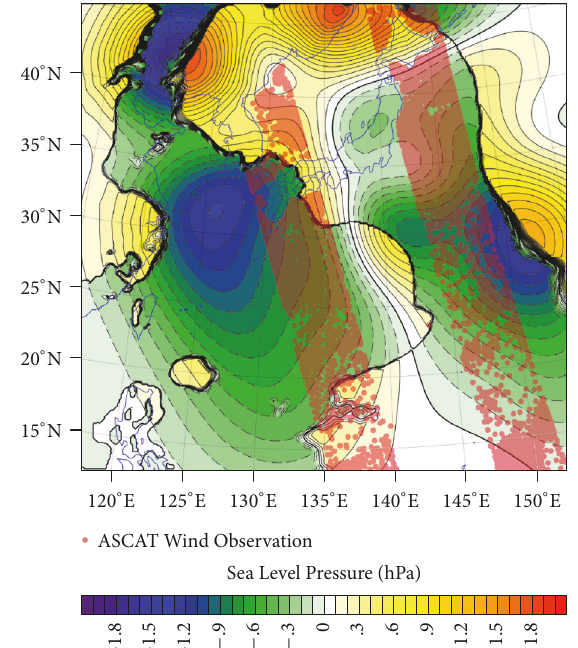
Figure 6: Pressure error improvement using superobbing with feature box compared with regular box (the red circles indicate the ASCAT wind observation location in the map).